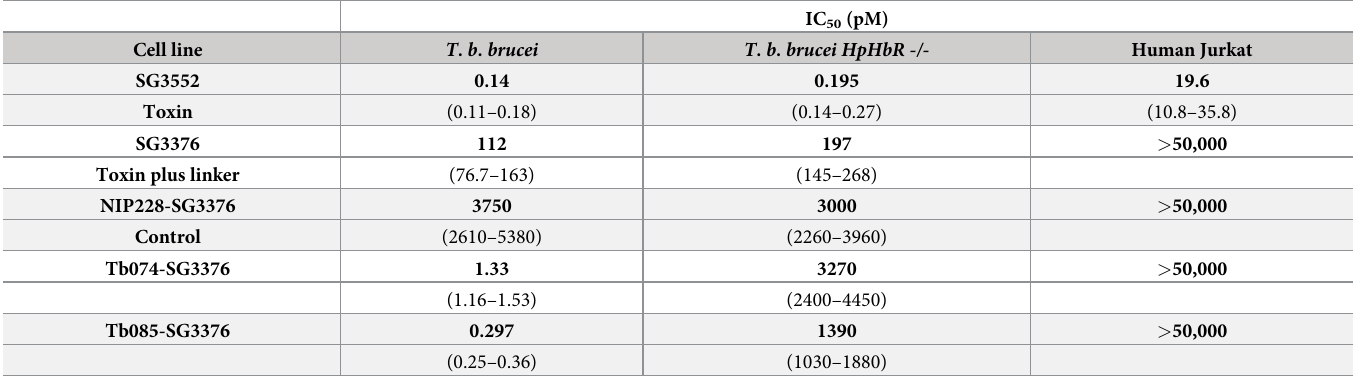
Table 1. IC 50 values (pM) of SG3552-based toxins and ADCs against T . brucei cell lines and a human Jurkat cell line. The IC 50 values of toxin SG3552, toxin plus linker SG3376, a control ADC (NIP228-SG3376) and two anti-trypanosome ADCs targeting the T . b . brucei HpHbR (Tb074-SG3376 and Tb085-SG3376) against T . b brucei wild type and T . b brucei HpHb -/- (Fig 3B) were calculated. Values in bold are best-fit IC 50 values, the range is the 95% confidence intervals. It was not possible to calculate accurate IC 50 values for the Jurkat cell line due to lack of saturation of the cell killing assay and so all were conservatively estimated as greater than 50 nM from the data in S2 Fig. All values are shown to 3 significant figures. IC 50